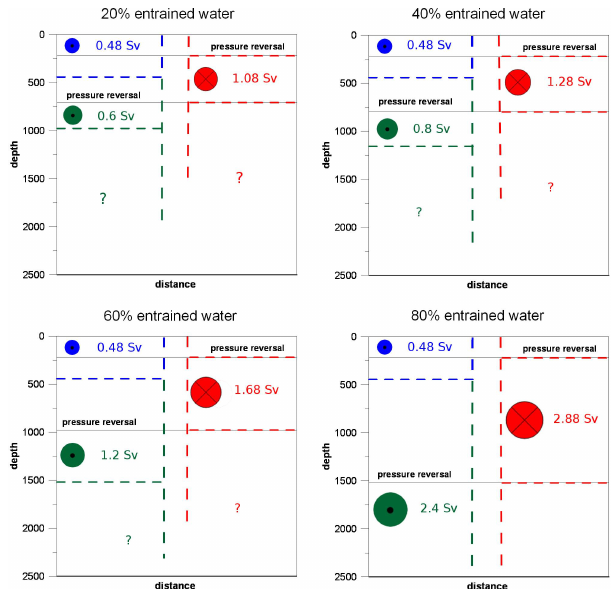
Fig. 22. Idealised baroclinic exchanges through Fram Strait. Half of the Polar water in the low salinity upper layer is assumed to be transformed by ice formation and brine rejection on the shelves, in- creasing the salinity to 35, and the shelf water sinks down the slope entraining ambient (Atlantic) water. The increased density in the lower layer creates a second pressure reversal and a deep southward flow is generated. However, the deep flow does not cease, when mass balance is reached and the sea level in the Arctic Ocean will drop, adding a barotropic component to the northward Atlantic flow to conserve mass. The southward flow of Polar water is above the first pressure gradient reversal, but Polar water is found down to the horizontal dashed blue line. The northward flow of Atlantic water occurs between the pressure gradient reversals but the entire eastern water column consists of Atlantic water. The deep Arctic Ocean water is located below the dashed blue line but the southward flow only takes place below the second pressure reversal. The horizon- tal dashed green line indicates the depth, where mass balance is